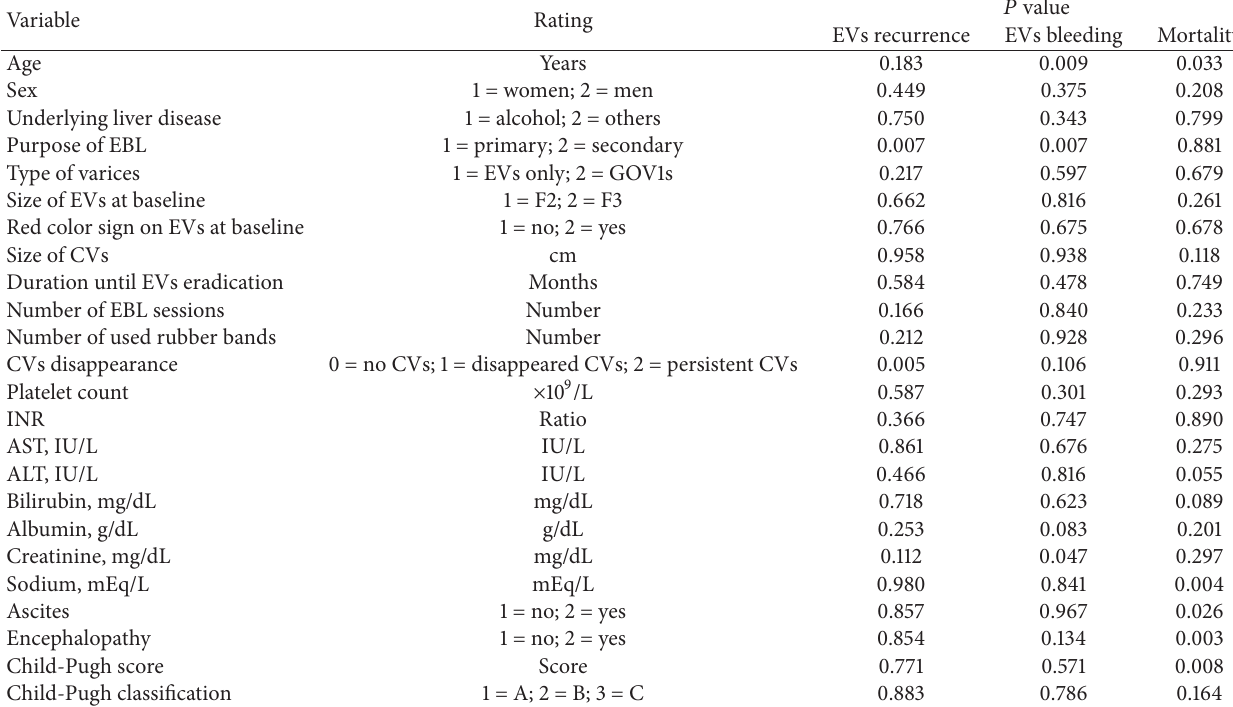
Table 3: Univariate Cox regression analysis for EVs recurrence, variceal bleeding, and mortality after EVs eradication by EBL. Variable